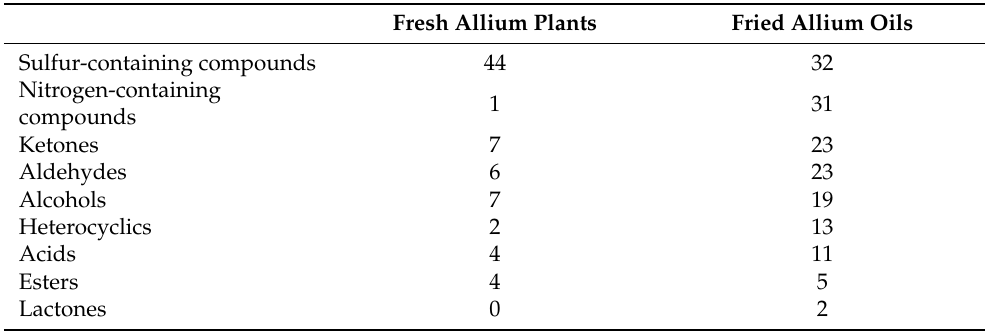
Table A5. The number of volatile compounds in fresh Allium plants and their fried oils identified in GC-MS